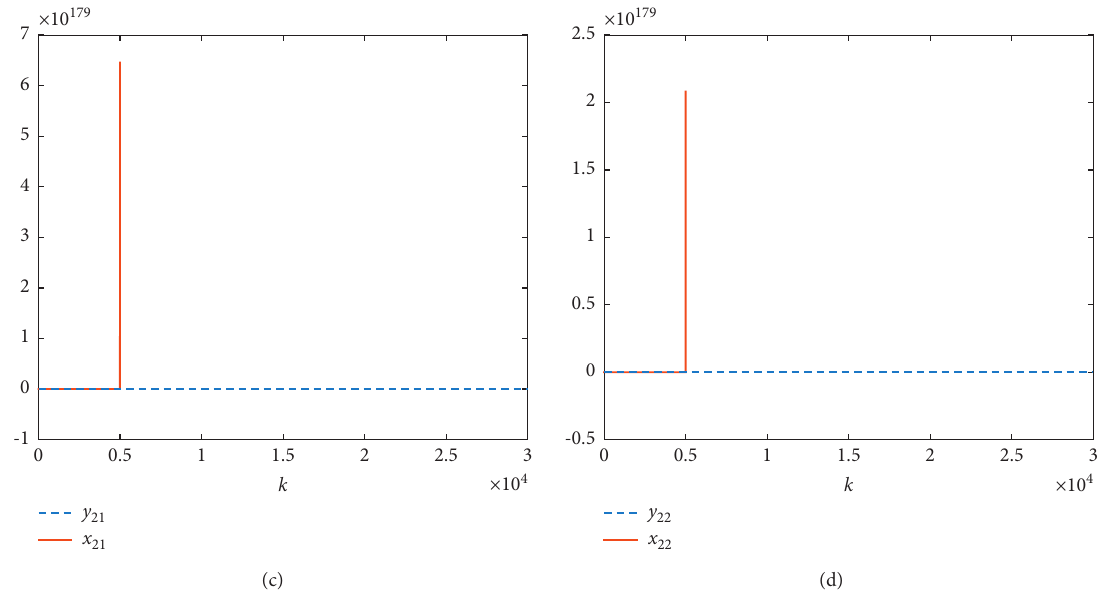
Figure 6: Solution trajectories synthesized by Y (a) Trajectories of y